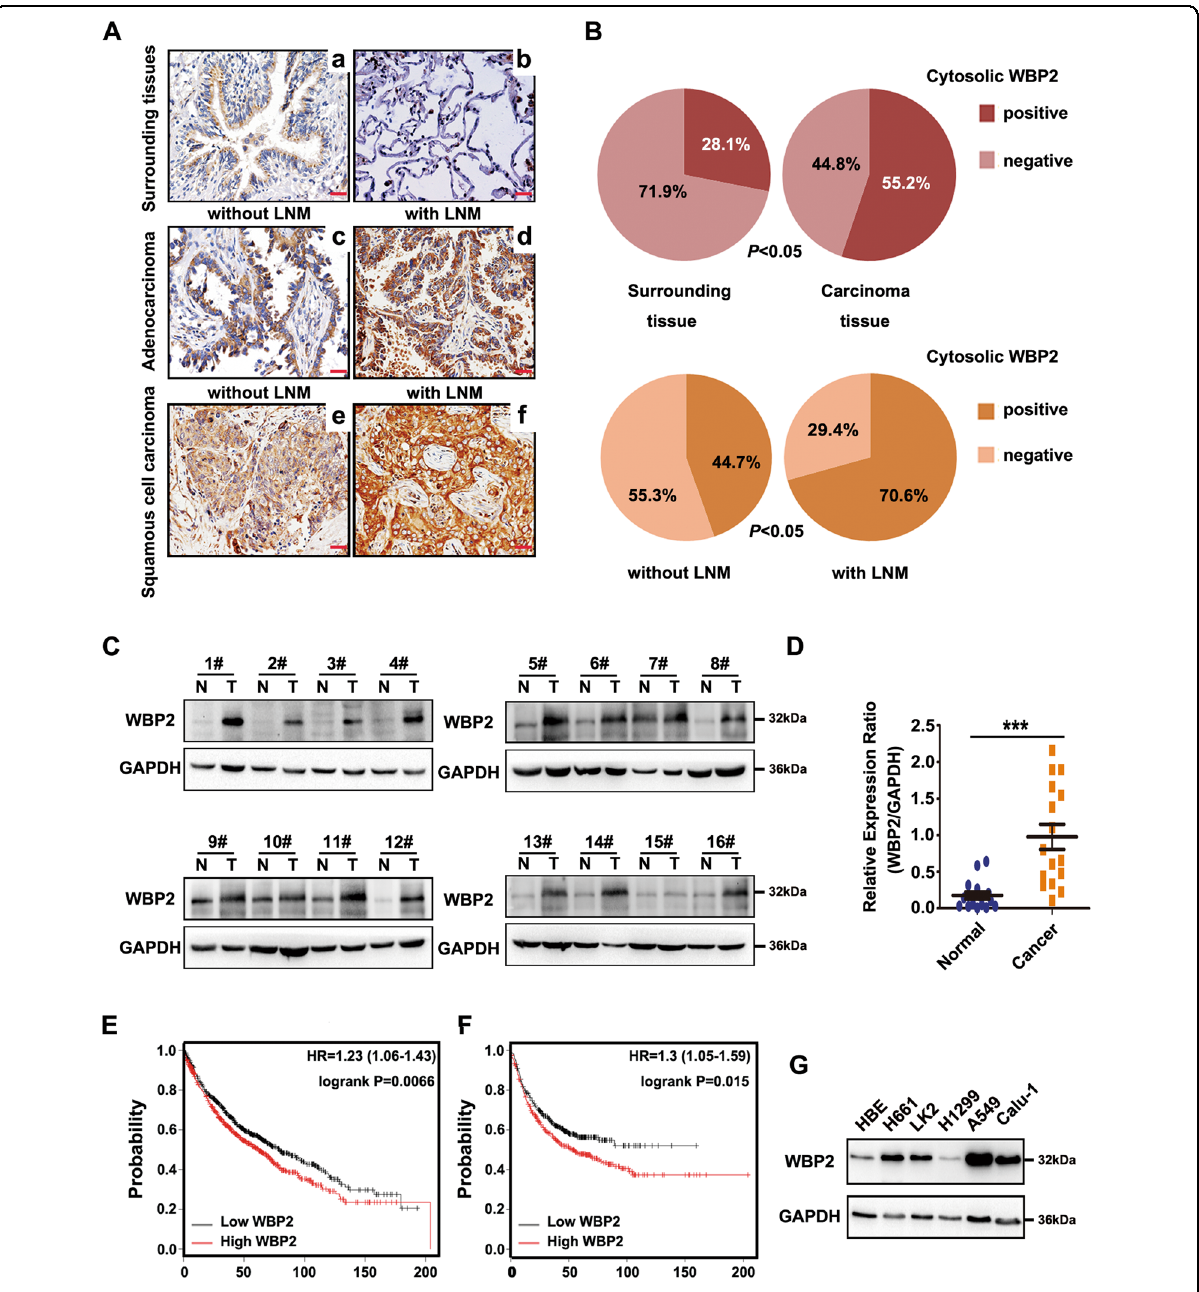
Fig. 1 High expression levels of WBP2 in non-small cell lung cancer correlate with poor prognosis. A , B The expression of WBP2 is low or negative in normal bronchial epithelium ( A – a ) and alveolar epithelium ( A – b ), positive ( + − ++ ) in adenocarcinoma ( A – c ) and squamous cell carcinoma ( A – e ) without lymph node metastasis (LNM), and strongly positive ( ++ − +++ ) in adenocarcinoma ( A – d ) and squamous cell carcinoma ( A – f ) with LNM. Magni fi cation: ×400, scale bar: 50 μ m. LNM: lymph node metastasis. C , D Western blot analysis revealed that the expression level of WBP2 in lung cancer tissues is signi fi cantly higher than that in adjacent normal lung tissues. GAPDH was used as the loading control. E , F Kaplan – Meier plotter network database analysis indicates that the overall survival (OS; E ) and progression-free survival (PFS; F ) of patients with lung cancer presenting high WBP2 expression are signi fi cantly lower than those of patients with low WBP2 expression. G Western blot analysis of WBP2 expression in the human immortalized bronchial epithelial cell line HBE and in a panel of non-small cell lung cancer cell lines ( n = 5). GAPDH was used as the loading control. P < 0.05 indicates statistical signi fi cance, and *** represents P <